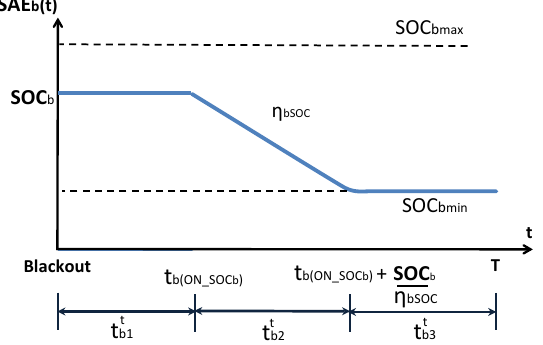
Figure 5. Generalized characterization curve of a restoring